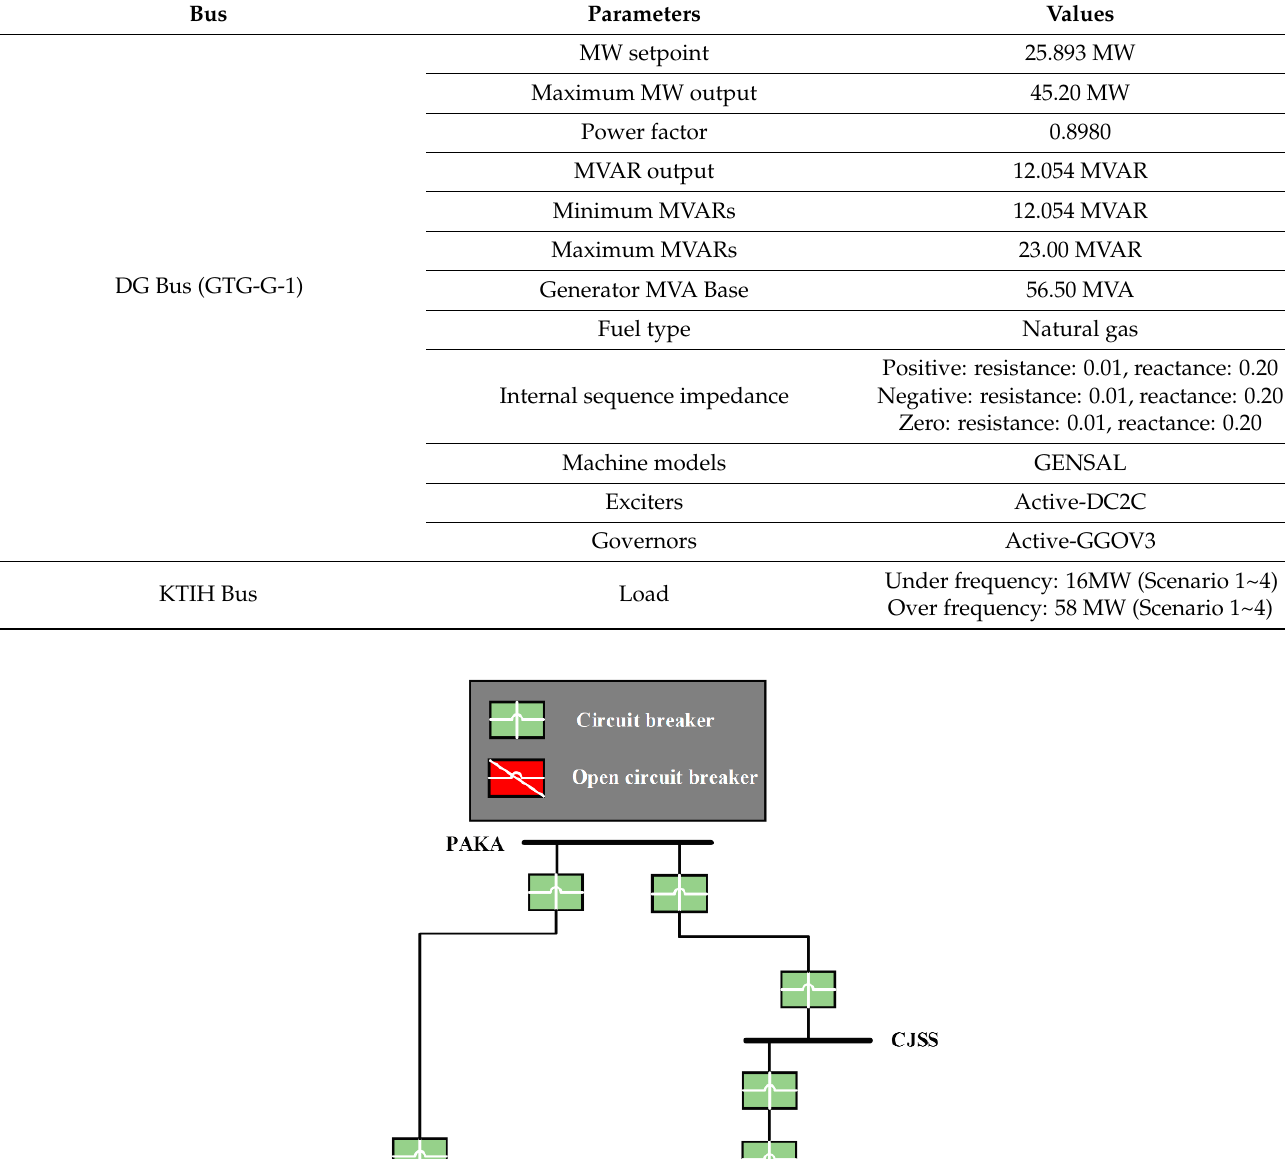
Table 2. Setting of parameters of the test system.